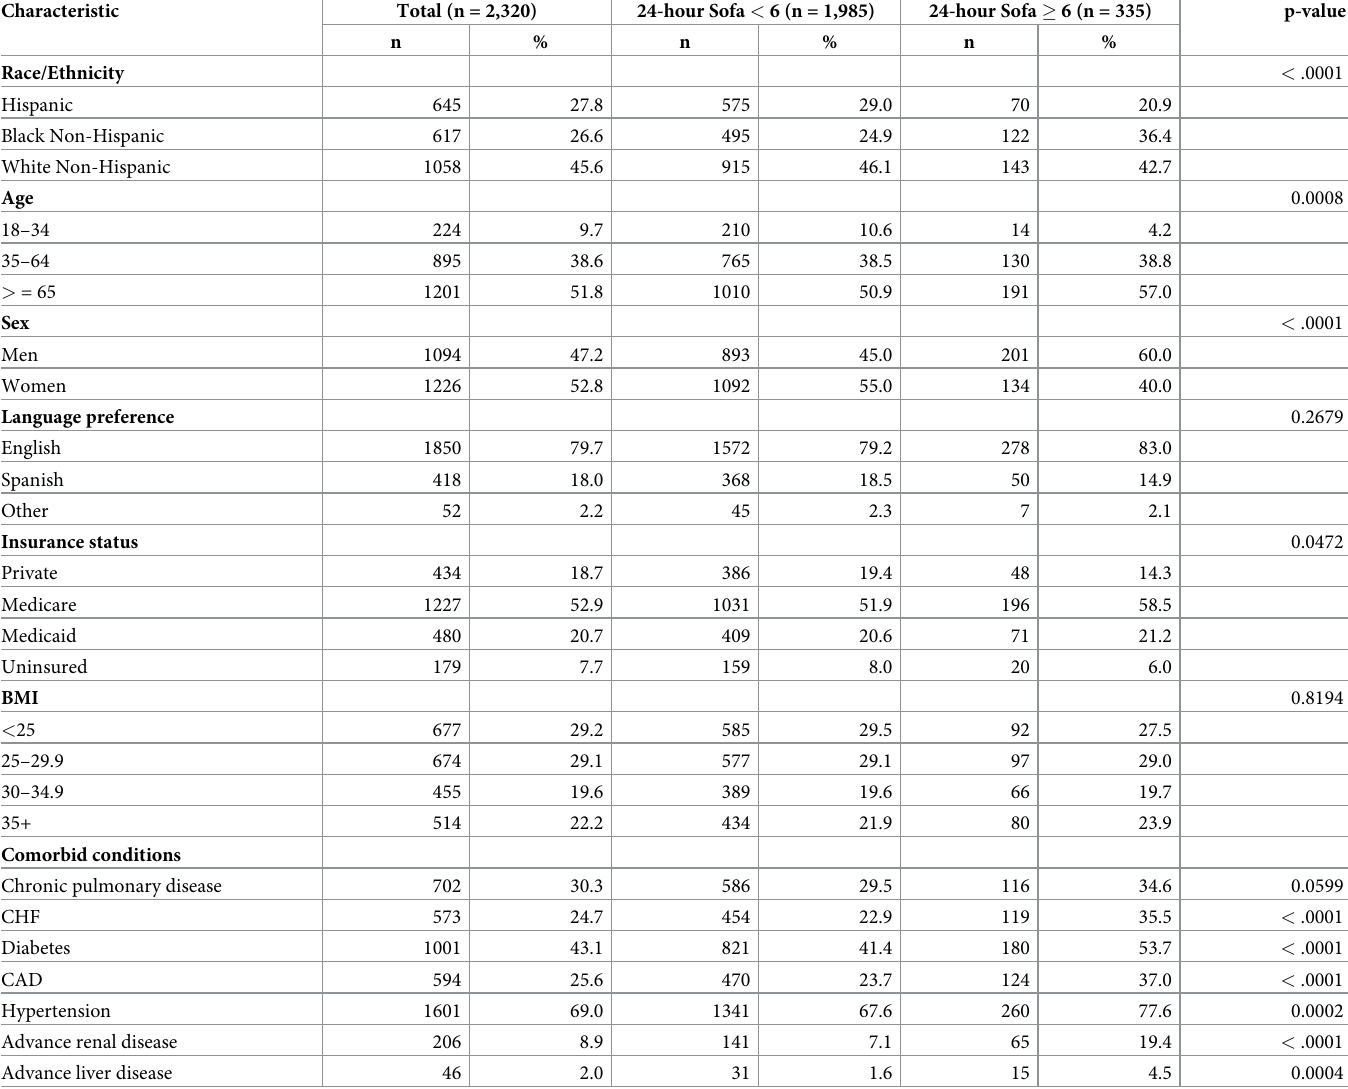
Table 1. Characteristics of COVID+ patients with SOFA within 24 hours of admission; SOFA < 6 and �